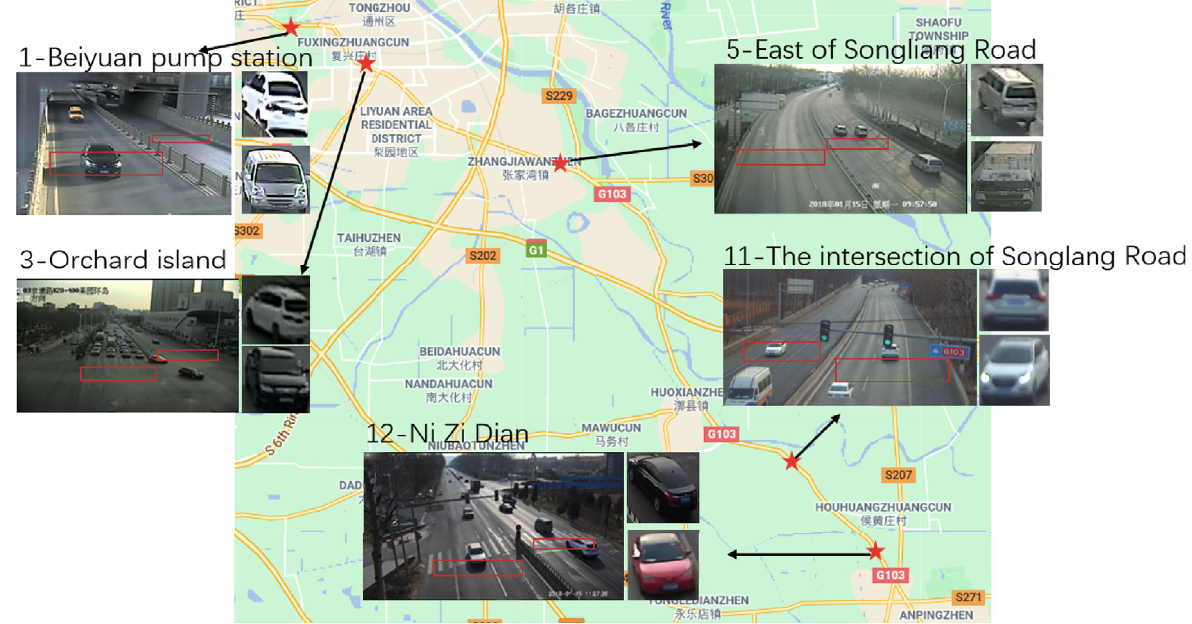
Figure 3: Points distribution and vehicle orientation in the direction of leaving Beijing.